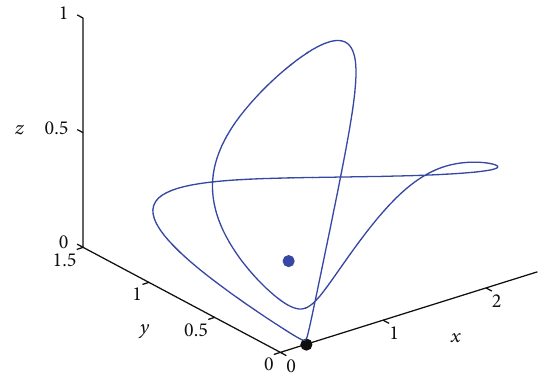
Figure 3: Stable limit cycle is shown when 𝐴 = 0.01 , 𝑚 = 0.4 , 𝑏 = 0.2 , 𝑑 = 0.8 , 𝑐 = 0.2 , 𝛽 = 2.4 , 𝛼 = 2.4 , ℎ = 1.2 , and 𝜔 = 0.6 , where black solid dot is a saddle and the blue solid dot is a saddle